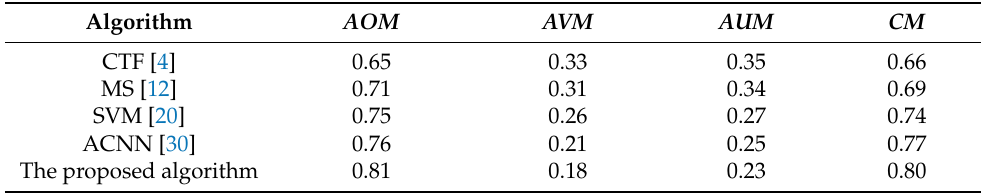
Table 2. Cloud detection results of database